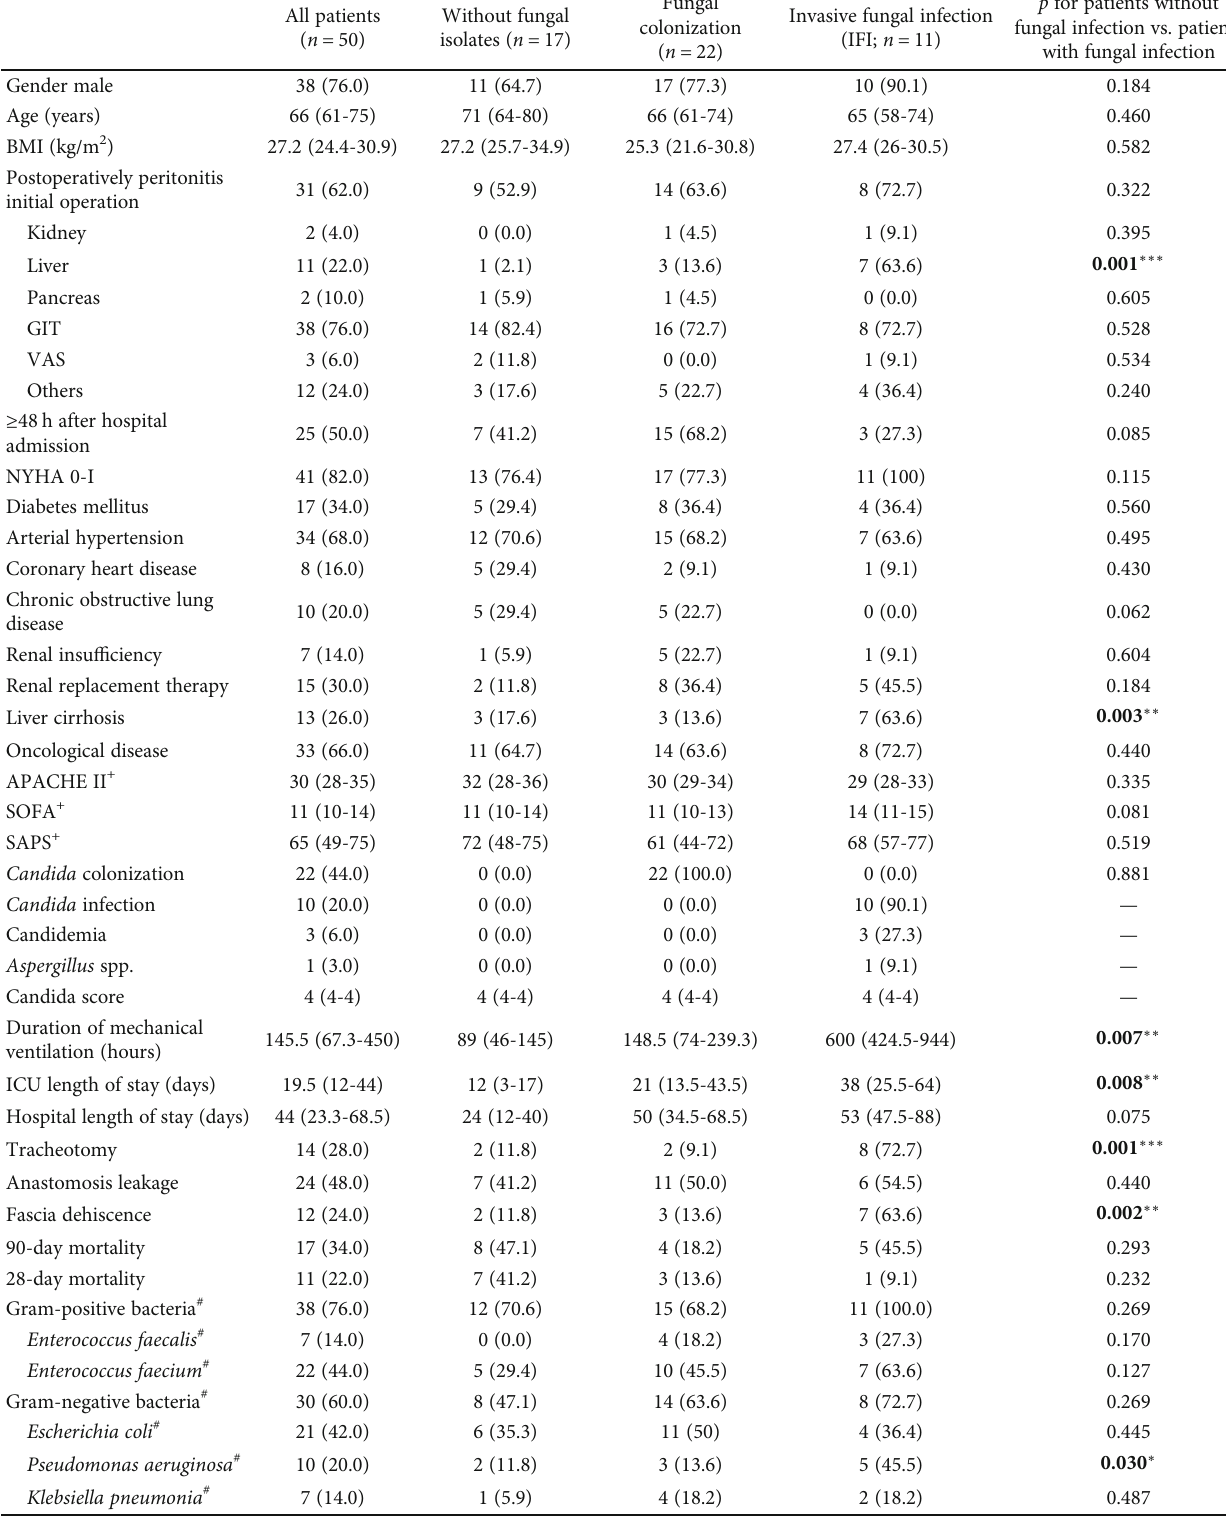
Table 1: Patients ’ characteristics ( n = 50